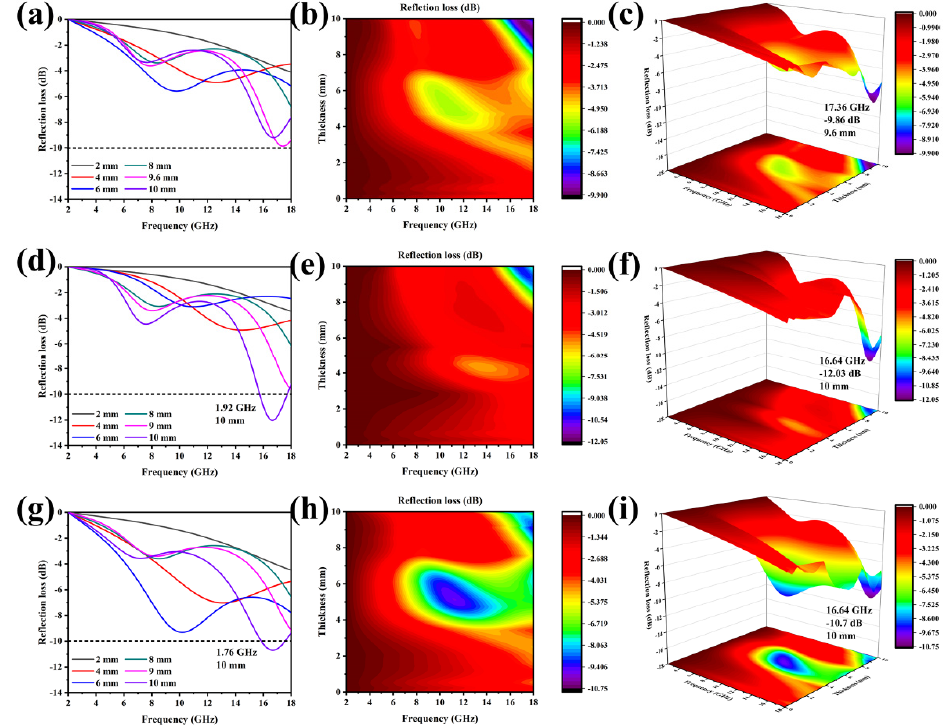
Figure 5. One-dimensional, 2D, and 3D diagram of the RL value changing with frequency and thickness: ( a – c ) Co 2 SiO 4 @DE-3, ( d – f ) Co 2 SiO 4 @DE-6, and ( g – i ) Co 2 SiO 4